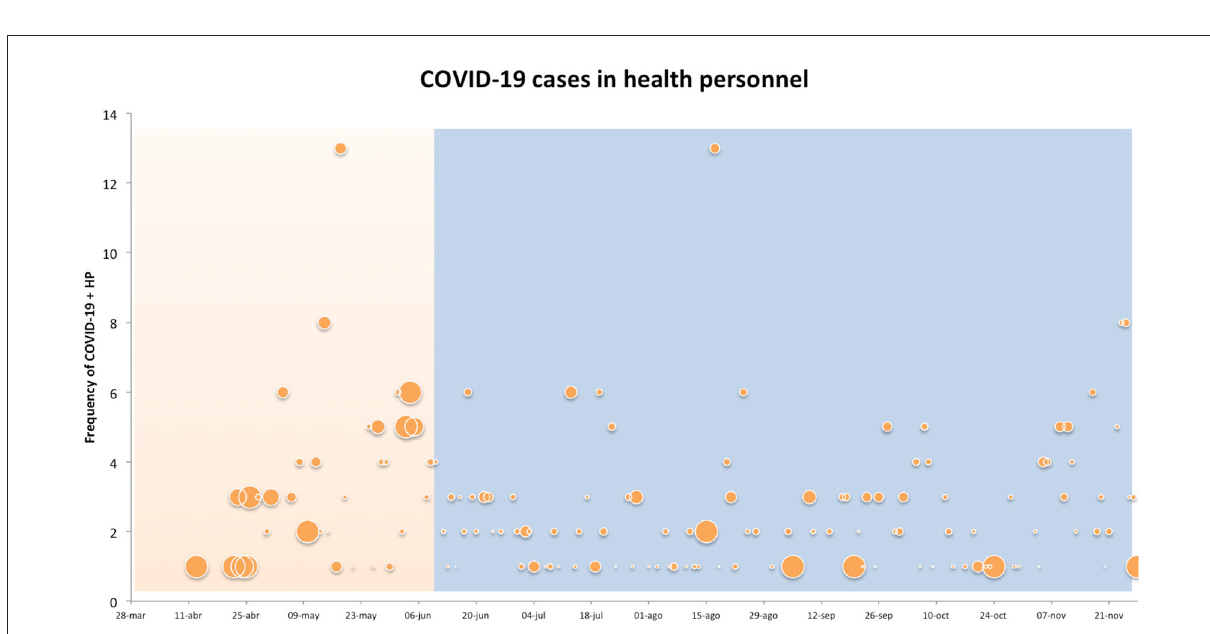
FIGURE2 Orange and blue shades represent period 1 and 2 respectively. The size of the circles indicates the percentage of COVID-19 and HP tests. The large circles represent 100%, the medium circles 50% and the small ones